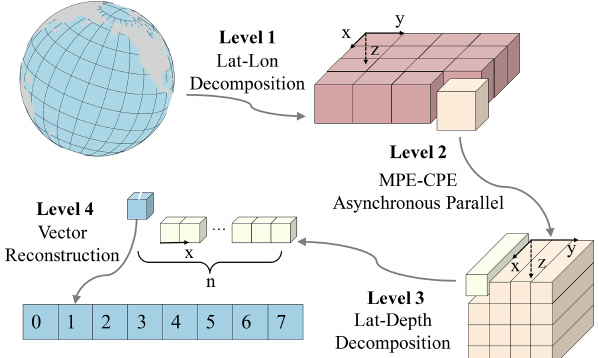
Figure 3. The adaptive four-level parallel framework, where x , y and z axes indicate latitude, longitude and depth, respectively. Level 1 is the load-balanced longitude–latitude decomposition among MPEs, level 2 is the asynchronous parallel between a MPE and a CPE cluster, level 3 is the latitude–depth decomposition in a CPE clusters and level 4 is the vector reconstruction in a